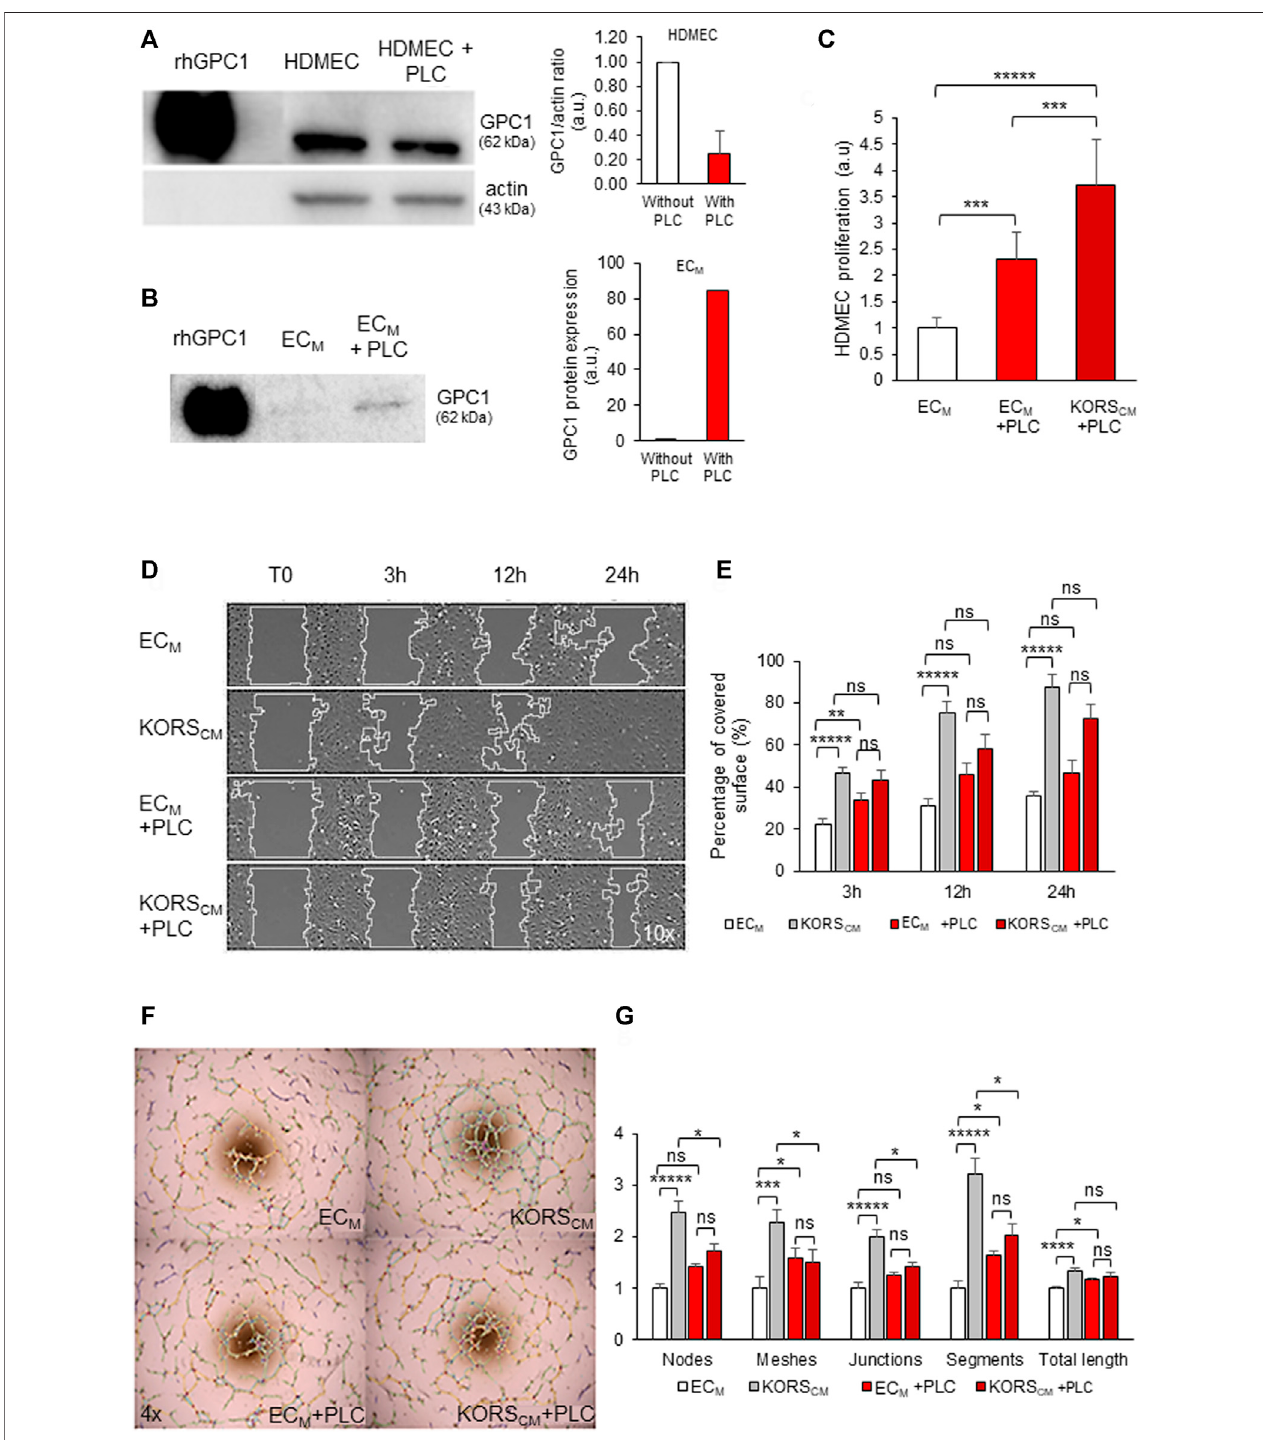
FIGURE 7 | Effect of PLC incubation on HDMEC proliferation, migration and pseudotube formation. (A,B) HDMECs were treated with 0.5 U/mL PLC for 1 h at 37 ° C. Total cell proteins (A) and conditioned EC M medium proteins (B) were extracted, analyzed by Western immunoblotting and quanti fi ed for GPC1 protein expression. (C) HDMEC proliferation wasmeasured by colorimetric assay using WST-1 dye in basal EC M , EC M + PLC or KORS CM + PLC for 24 h and expressed as the mean ± SD, n (cid:2) 8 replicates and twoindependentexperiments. (D,E) The migration ofHDMECsin EC M and KORS CM withor withoutPLC (24 hofincubation) was observed (D) and quanti fi ed as percentage of recovery (E) . The results are expressed as the mean ± SEM, n (cid:2) 3 replicates and three fi elds were analyzed per replicate, two independent experiments (E) . (F,G) Pseudotube formation of HDMECs in EC M and KORS CM with or without PLC as observed 5 h after seeding (F) . The number of nodes, meshes, junctions, segments, and the total length were quanti fi ed and expressed as the mean ± SEM, n (cid:2) 5 replicates and three independent experiments (G) .